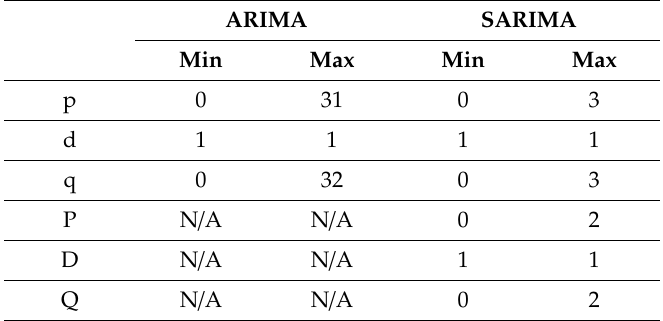
Table 2. Ranges of values for the di ff erent parameters of each